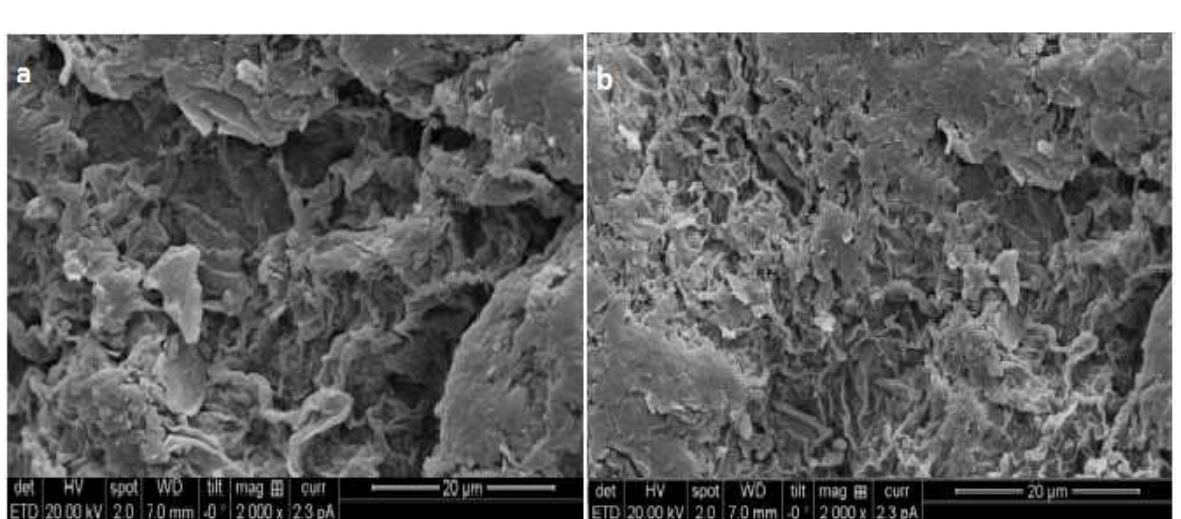
Figure 1. The Scanning electron microscopy (SEM) image of dried canola: (a) before use; (b) after